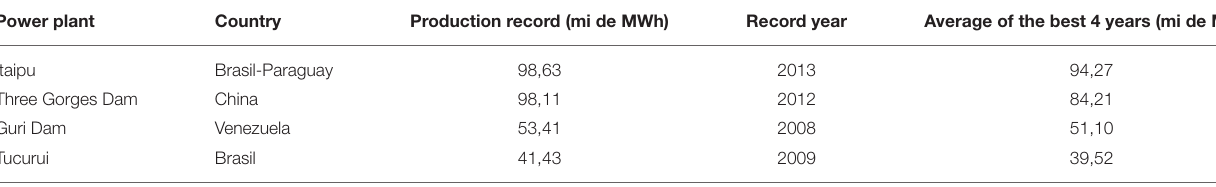
TABLE 1 | Hydropower production: comparison among the highest operating records in history.